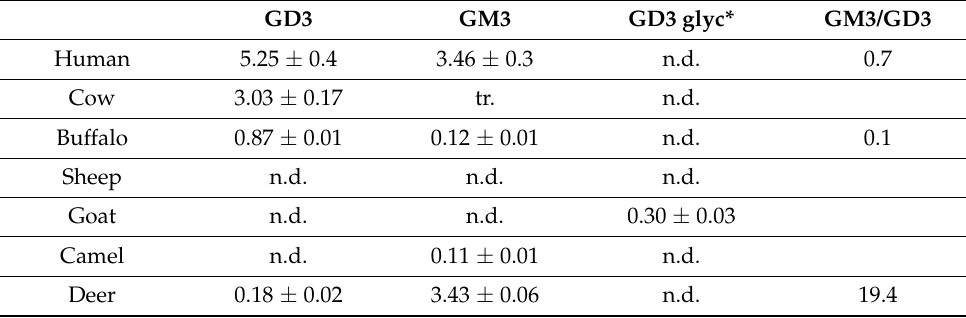
Table 4. Ganglioside content of the milks studied (in mg/100g of milk). GD3 GM3 GD3 glyc* GM3/GD3 Human 5.25 ± 0.4 3.46 ± 0.3 n.d. 0.7 Cow 3.03 ± 0.17 tr. n.d. Buffalo 0.87 ± 0.01 0.12 ± 0.01 n.d. 0.1 Sheep n.d. n.d. n.d. Goat n.d. n.d. 0.30 ± 0.03 Camel n.d. 0.11 ± 0.01 n.d. Deer 0.18 ± 0.02 3.43 ± 0.06 n.d.